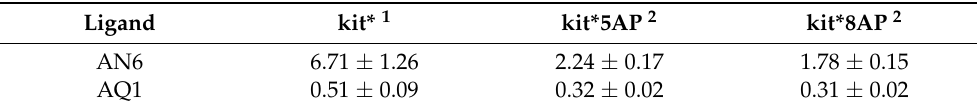
Table 2. Apparent dissociation constants (K d , µ M) of tested ligands for kit* determined by SPR or